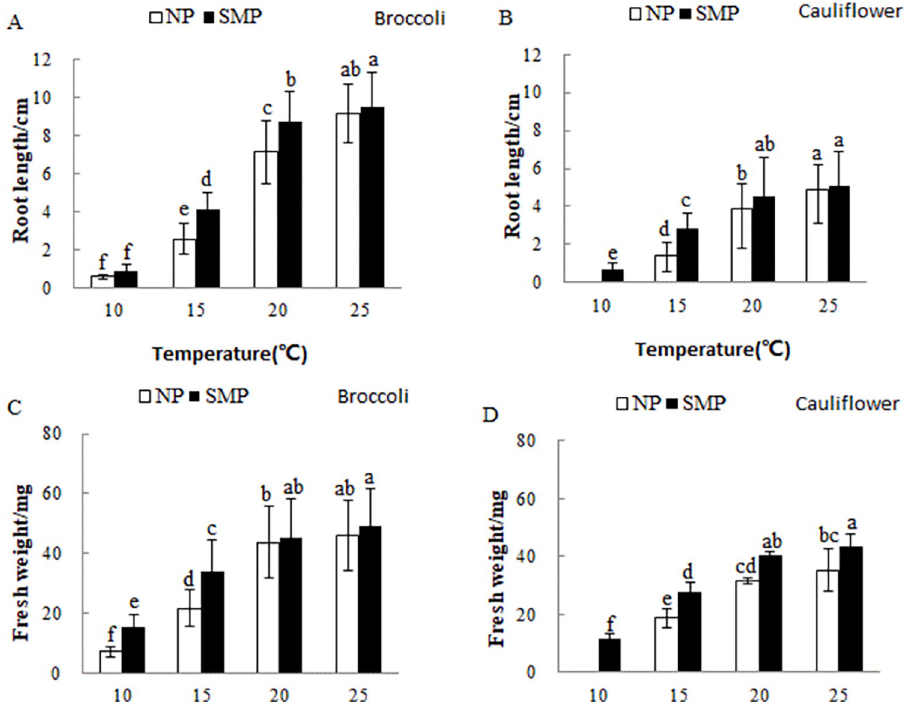
Fig 2. Effects of SMP on the early growth of cauliflower and broccoli seedlings at 10, 15, 20, and 25˚C. (A and B) Root length, and (C and D) fresh weight. The seeds of cauliflower and broccoli were germinated as described in Fig 1.